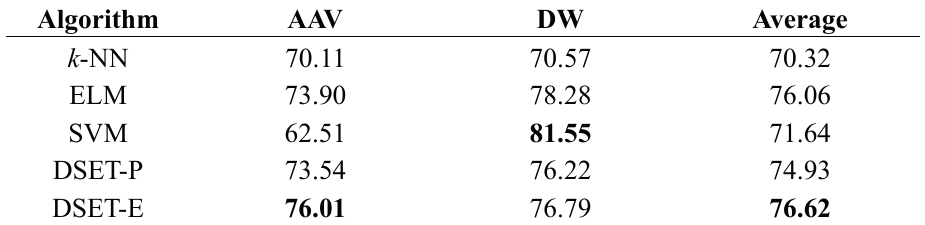
Table 3. Classification results of different